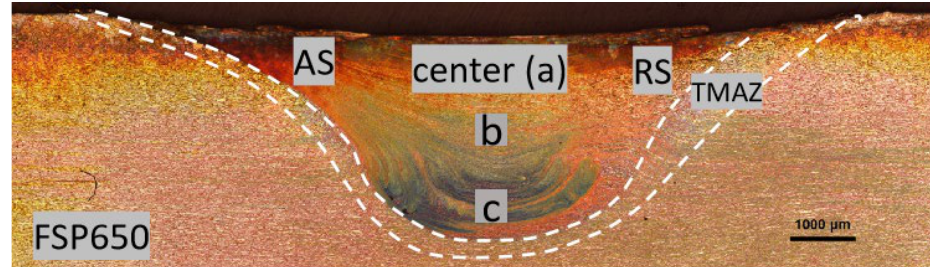
Figure 2. Cross-sectional view of the FSPed SAF 2507 taken with an optical microscope.